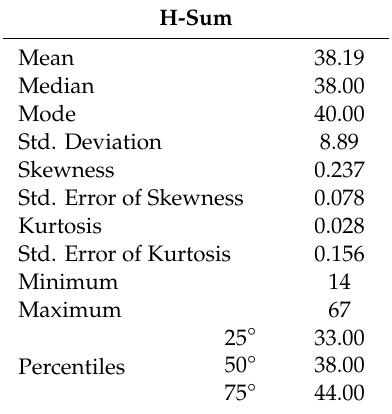
Table 1. Descriptives of the H-Scale in the study